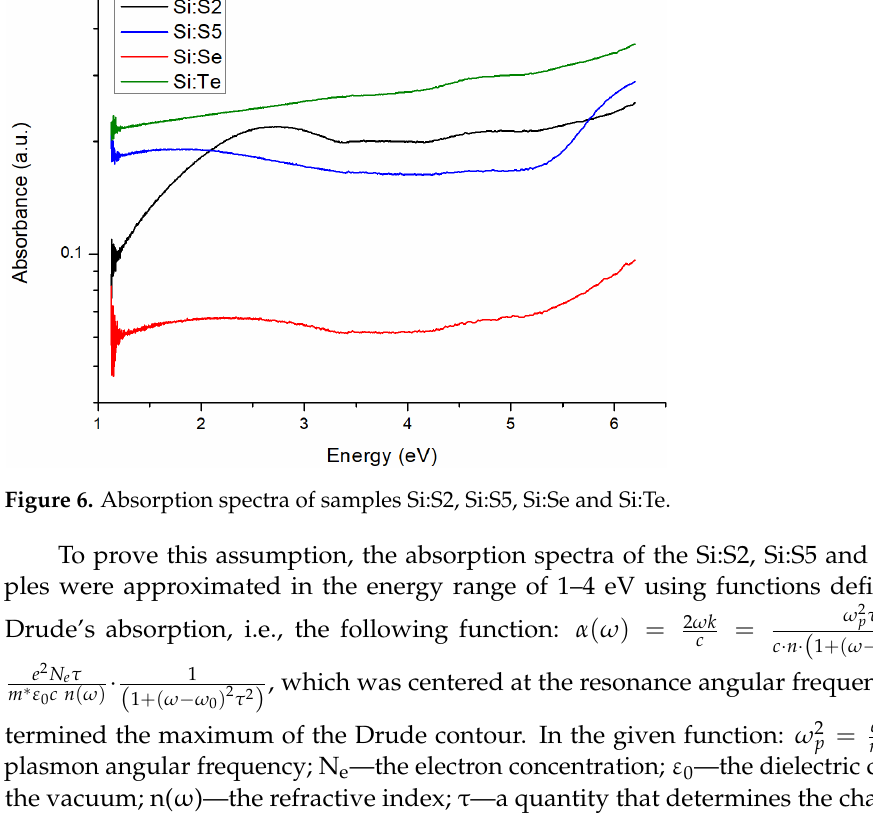
Figure 6. Absorption spectra of samples Si:S2, Si:S5, Si:Se and Si:Te.